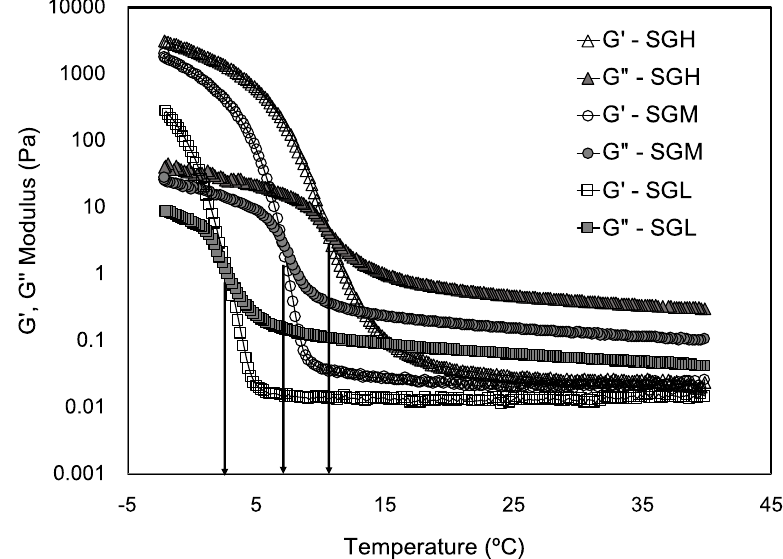
Figure 5. Viscoelastic parameters (G′ and G′′) of salmon gelatin with controlled molecular weight. Both moduli were assessed upon cooling and arrows indicate the gelling temperature of each SG sample.